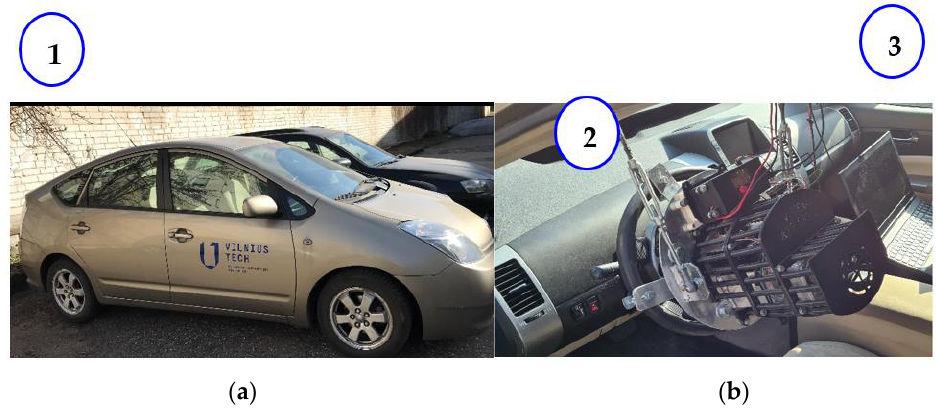
Figure 8. ( a ) The prototype of the first-level autonomous ground vehicle. ( b ) The automated steering device with the control computer.